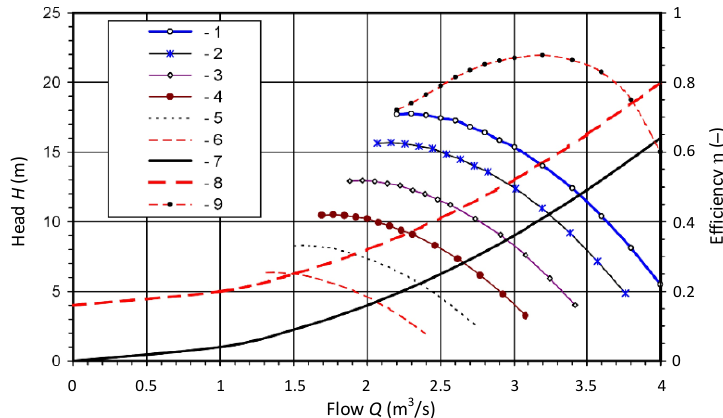
Figure 6. Waveforms of efficiency and head of water as a function of ОВ 2-87 v ertical pump’s c a- pacity.